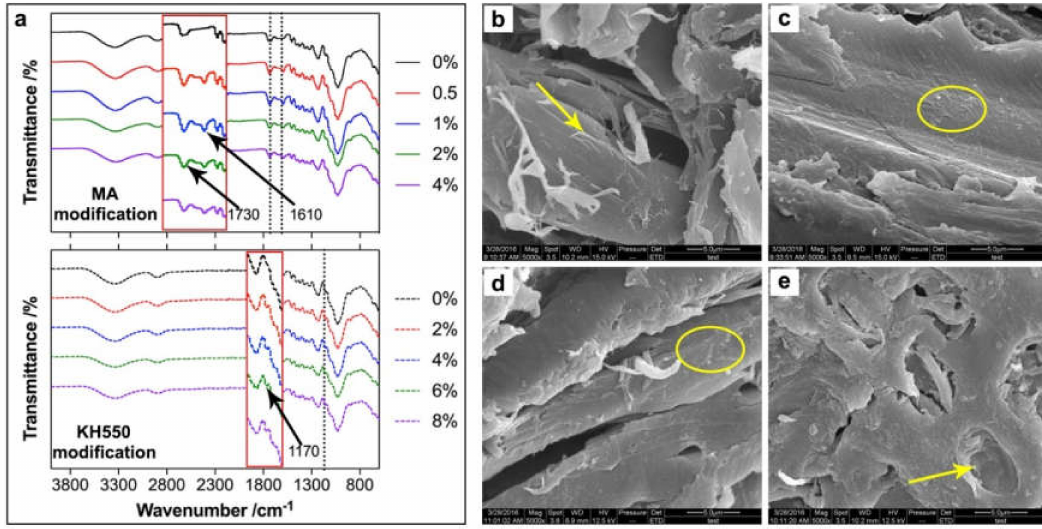
Figure 2. FTIR spectra ( a ) and morphologies ( b – e ) of the poplar fiber (b—unmodified; c—4% KH550-modified, e—8% KH550-modified; and d—4% MA-modified).